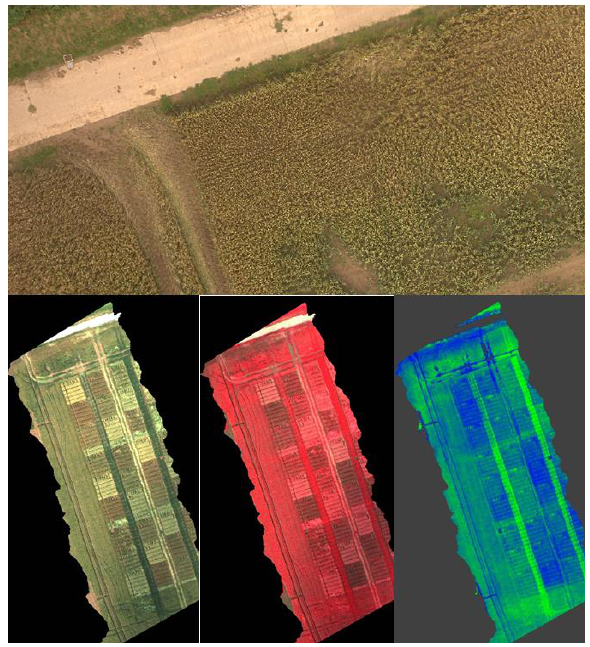
Figure 3.A view of data in a precision agriculture experiment. ( top ) High resolution RGB orthomosaic, ( bottom ) RGB, False color and NDVI visualizations of hyperspectral data